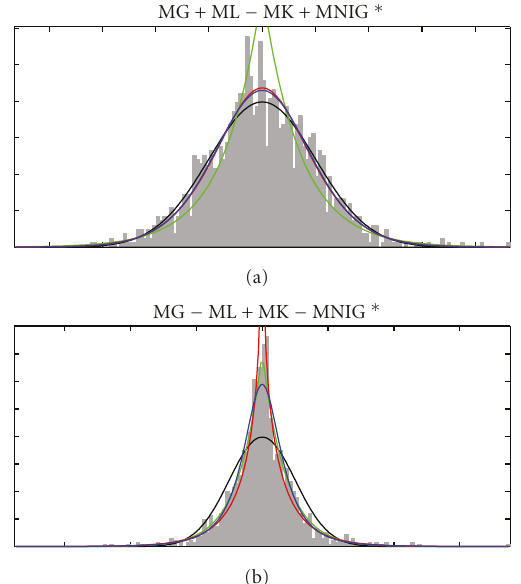
Figure 4: Examples of good-fit histograms showing that several models may have very similar fitting to the data, and from which we derived our 0 . 5% relative log-likelihood threshold. The top example shows that the MG (black), MK (red), and MNIG (blue, and the best-fit) are all acceptable fits to the data, whereas the ML (green) is not. The lower example shows that the ML and MNIG (best) are good fits, while the MG and MK are